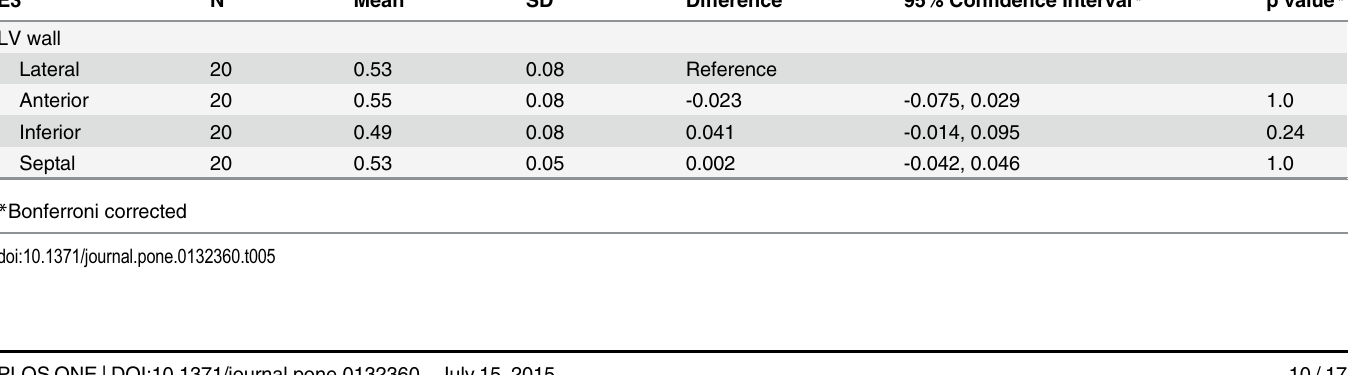
Table 5. E3 Regional Analysis (×10 -3 mm 2 s -1 ). Lateral wall used as the reference for statistical comparisons.